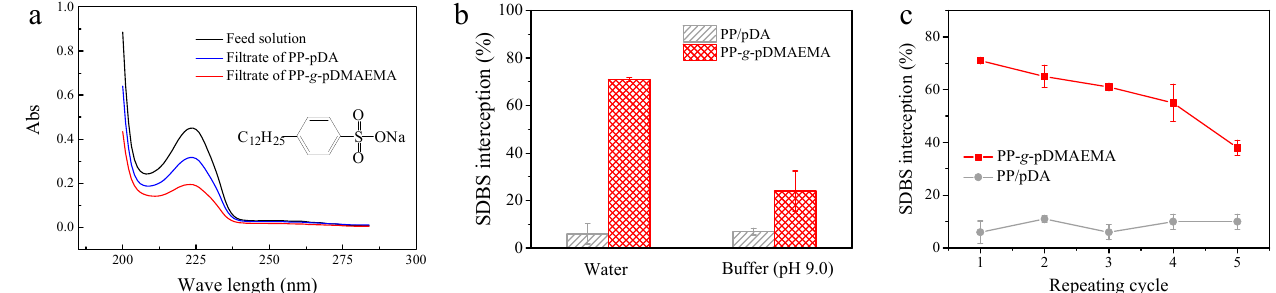
Figure 6. ( a ) The UV spectrum of SDBS feed solution and filtrates (the inset is the molecular structure of SDBS); ( b ) SDBS interception rate of PP-pDA and PP- g -pDMAEMA membranes in different pH levels; ( c ) SDBS interception rate of PP-pDA and PP- g -pDMAEMA membranes during five cyclic separations.